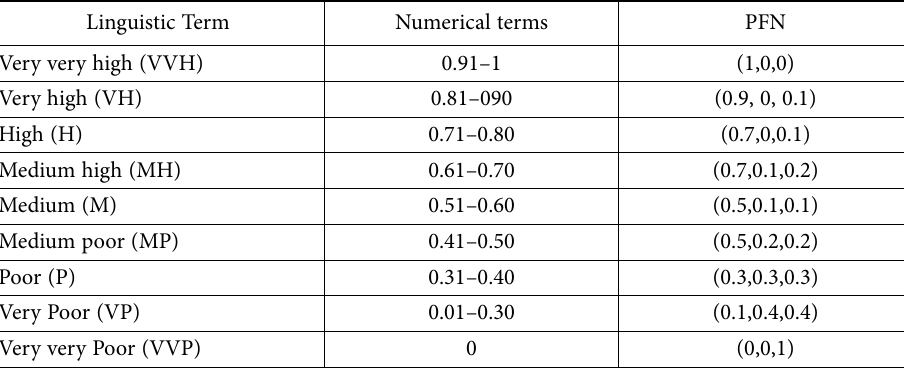
Table 2. The picture fuzzy linguistic and numerical scale Linguistic